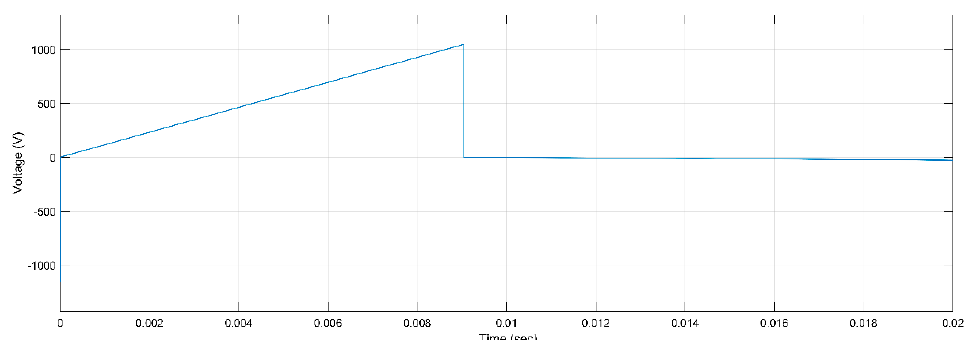
Figure 26. PD Activity for Mica, 5 kV, h, r.